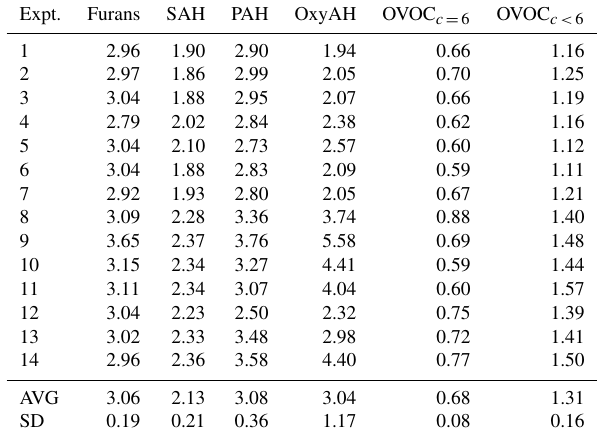
2. Reported average reaction rate constants (10 − 11 cm 3 molec. − 1 s − 1 ) towards OH per family at the be- ginning of each experiment, including average reactivity (AVG) and standard deviation (SD).